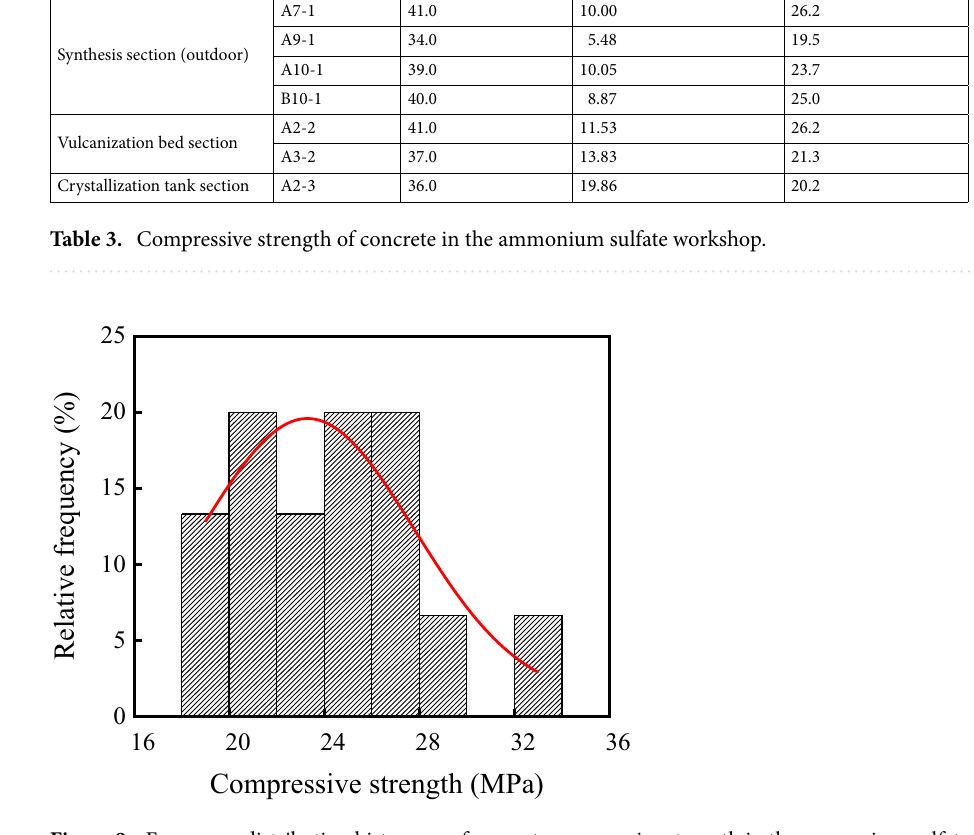
Figure 9. Frequency distribution histogram of concrete compressive strength in the ammonium sulfate